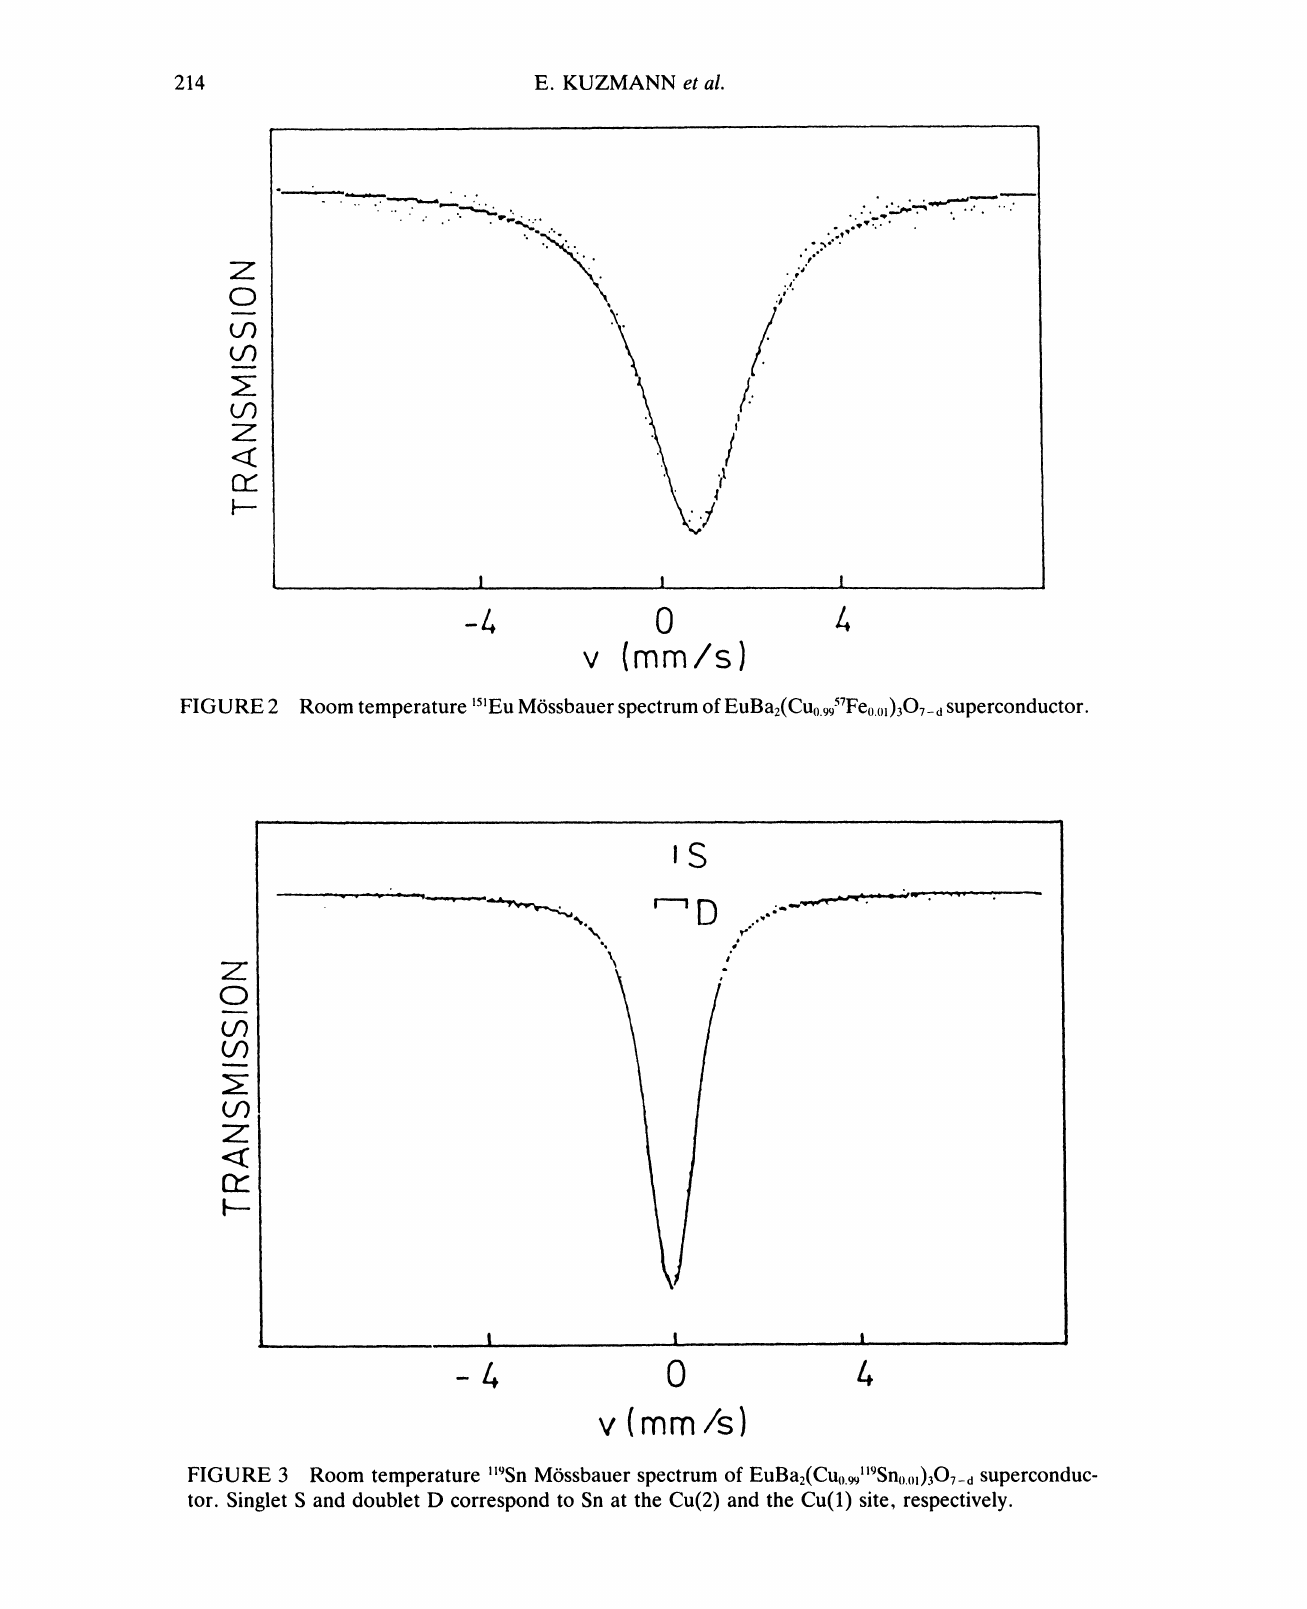
119 FIGURE 3 Room temperature ’gSn M6ssbauer spectrum of EuBa.(Cu0.99 Sno.o)3OT_d superconduc-